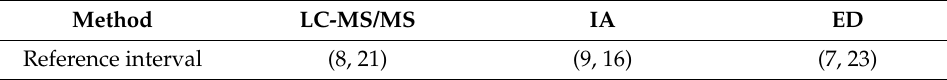
Table 2. Population reference intervals (pg/mL) for FT4 with three